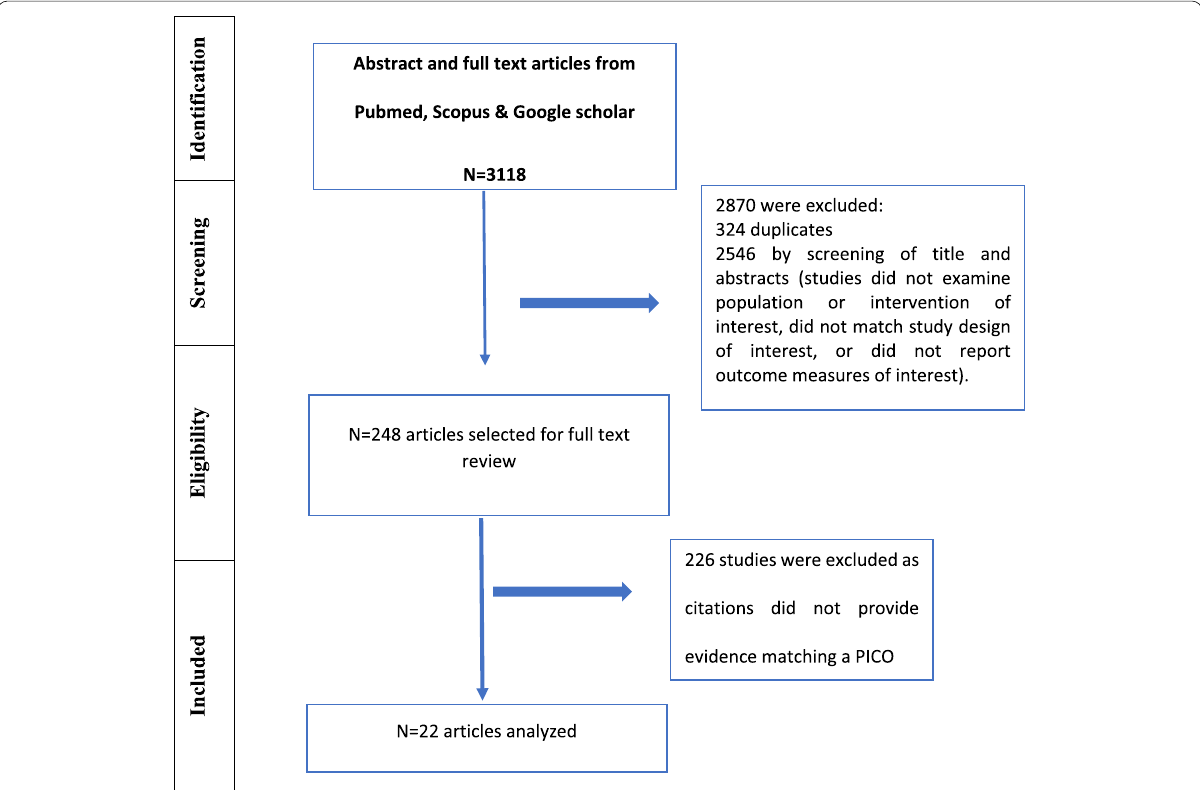
Fig. 1 Flow chart for the study selection